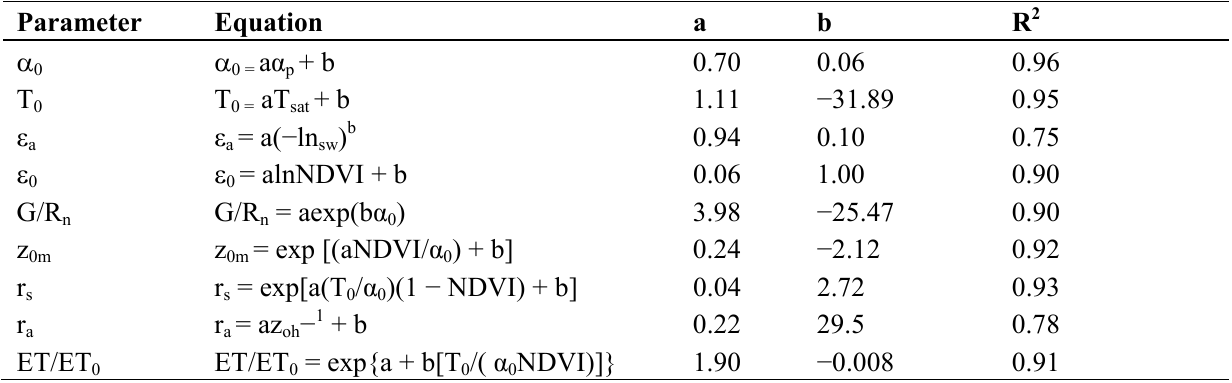
Table 1. Summary of the regression